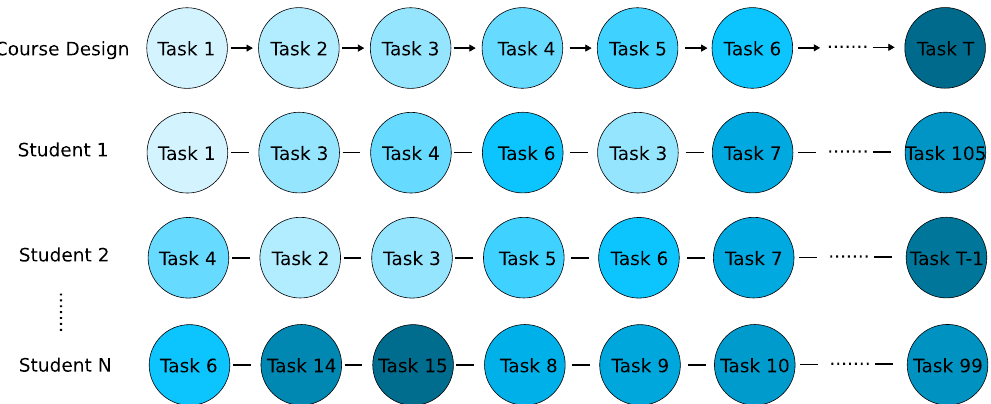
Figure 2. The sequence data framework represents each task as a node which is ordered according to the course learning design. Each student is represented by a sequence of tasks. This framework forms the basis for application of various data-driven analyses and Bayesian sequence